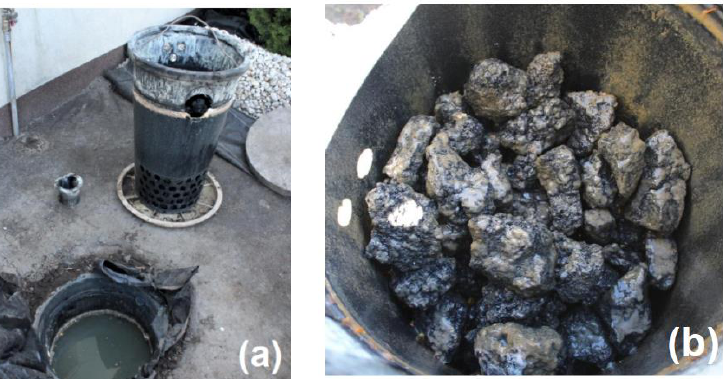
Figure 2. Filter basket filled with volcanic rock (pozzolana), installed on the septic tank outflow: ( a ) external view, ( b ) internal view.